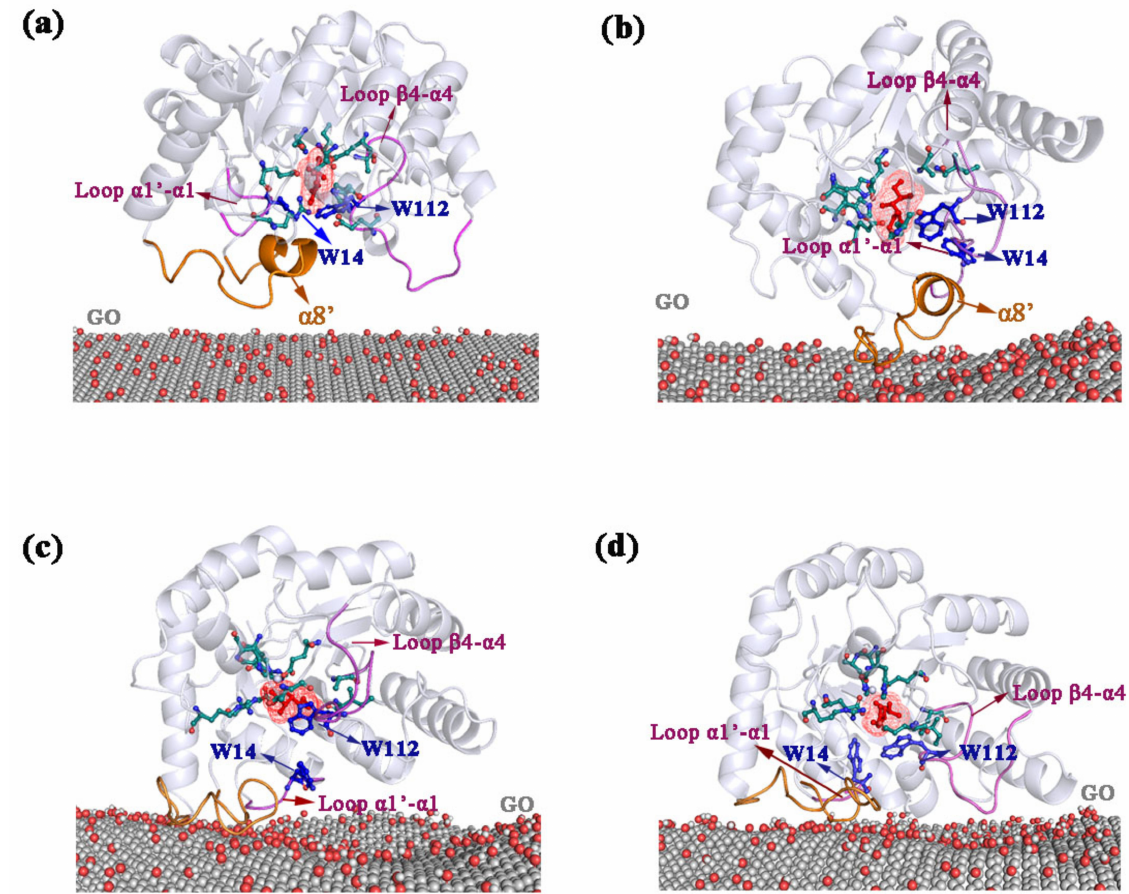
Figure 4. Adsorption process of enzyme on GO at 60 ◦ C. The representative snapshots of ( a ) 0 ns; ( b ) 30 ns; ( c ) 70 ns; and ( d ) 100